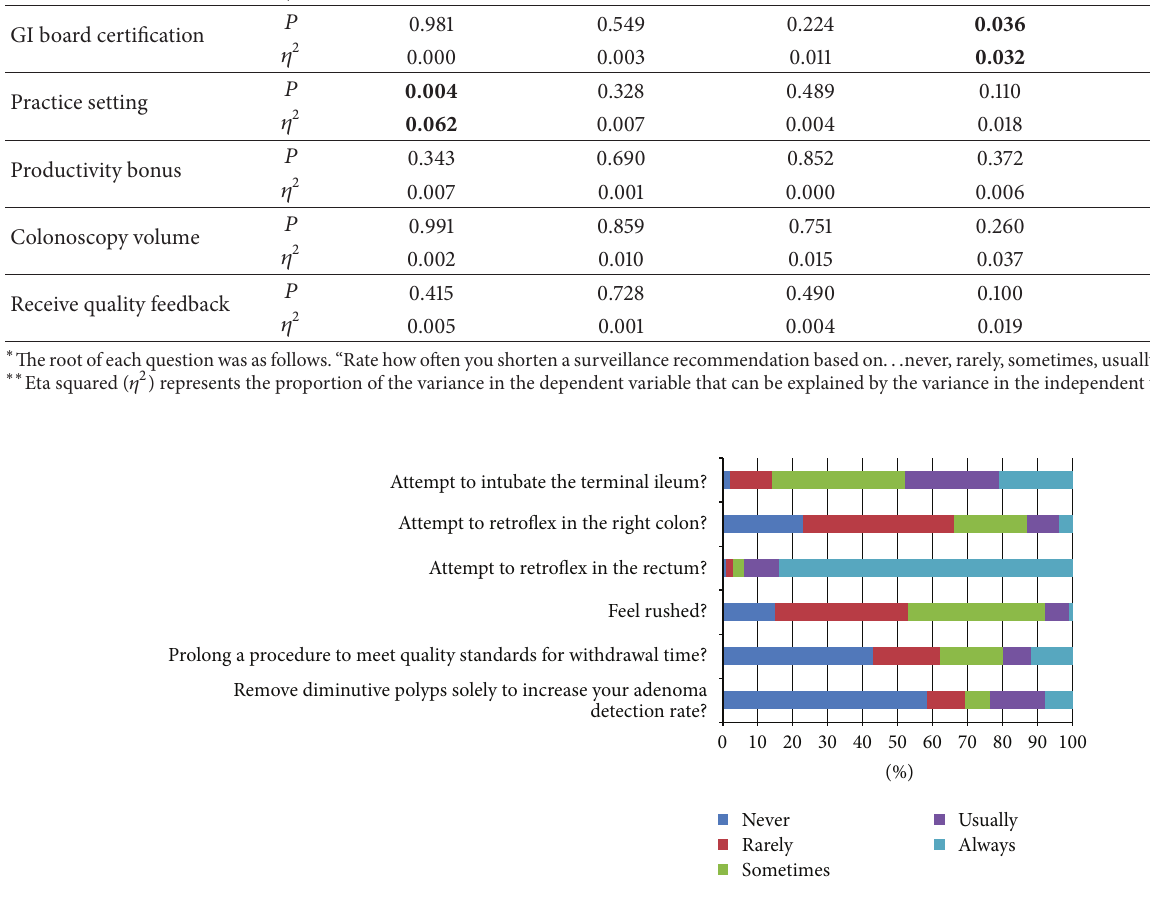
Figure 2: While performing screening and surveillance colonoscopies, how often do you . . .